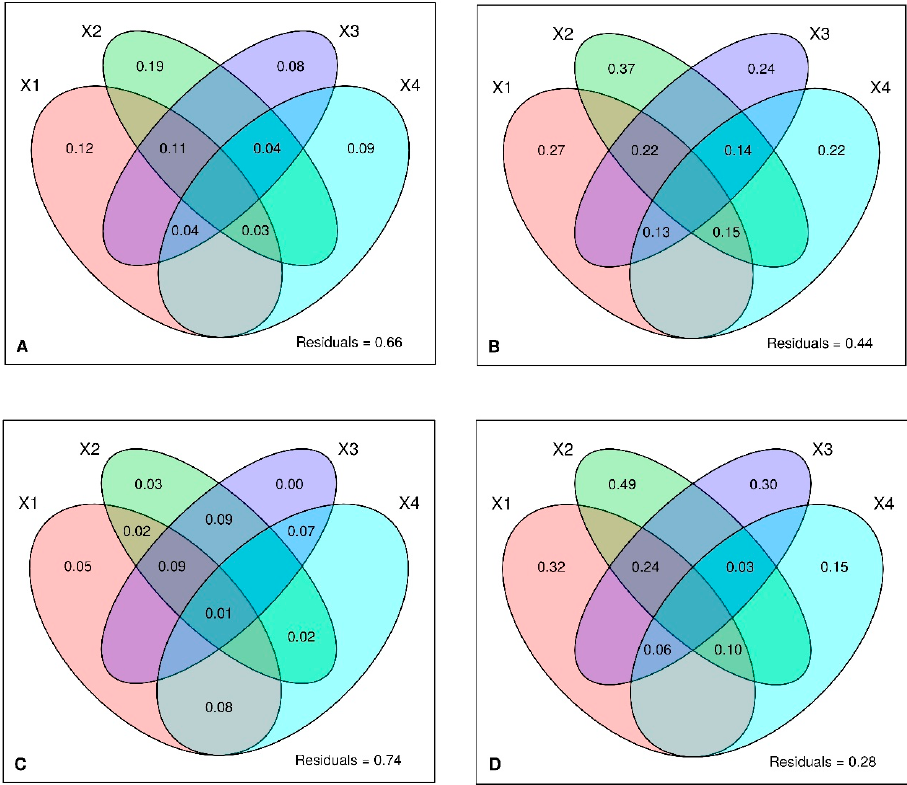
Figure 2. Variation partitioning of epiphytic lichen species composition among the main variable groups (values < 0 not shown): X1 = bioclimatic, X2 = topographical variables, X3 = parent rock, and X4 = stand structure variables: ( A ) LPA, ( B ) LFQ, ( C ) GLPA, and ( D ) GLFQ.